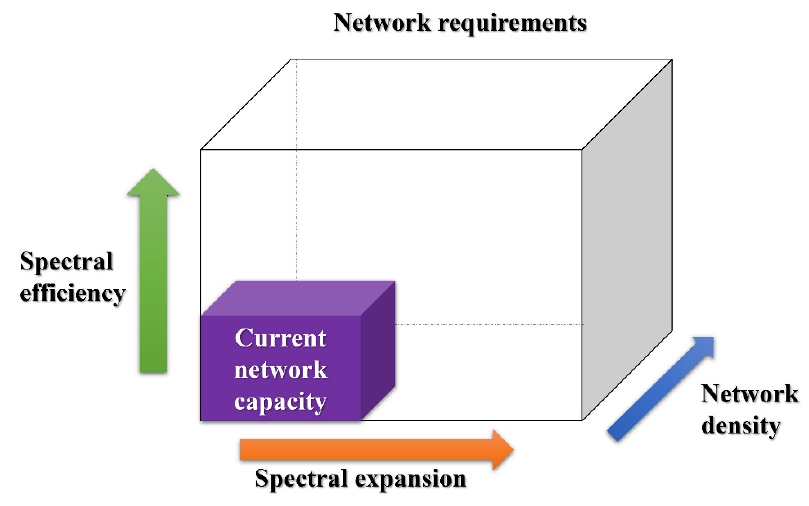
Figure 4. Evolution of mobile communication technologies. The evolution of spectral efficiency in mobile communications is shown in Figure 5.